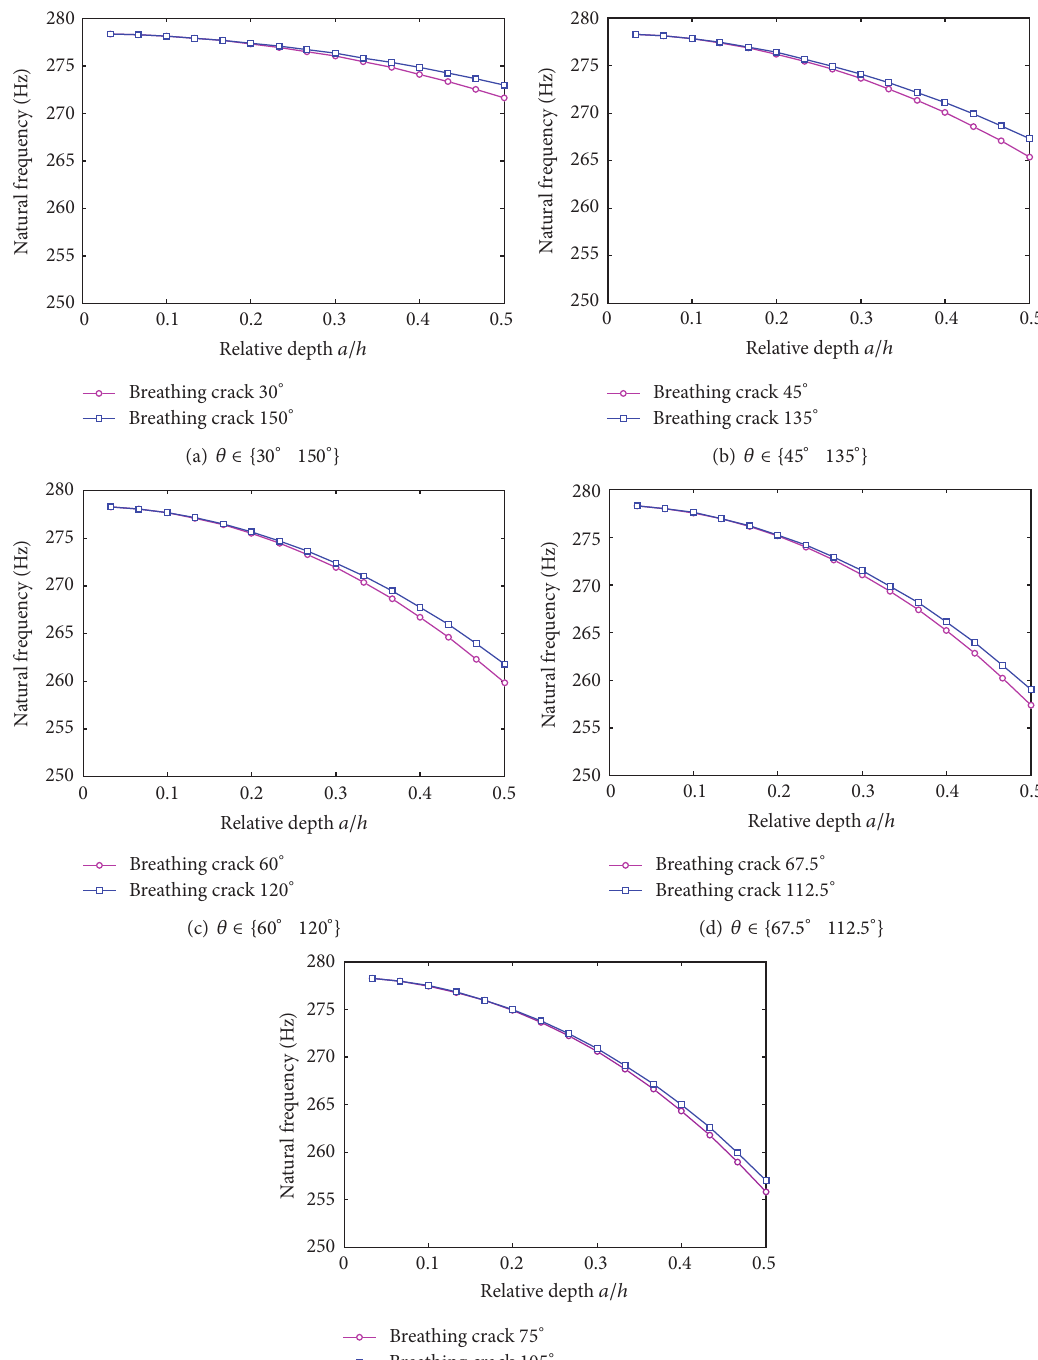
Figure 11: Comparison between the natural frequencies of the oblique crack with different angles.